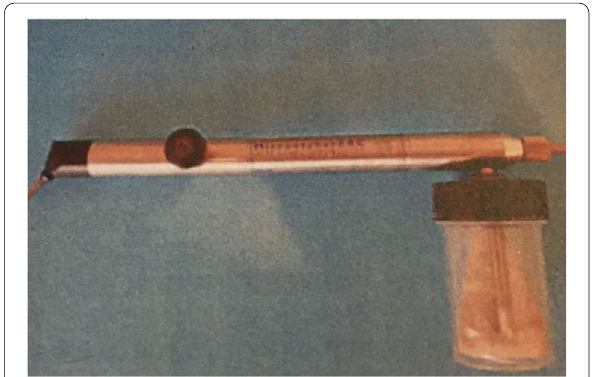
Fig. 3 Micro etcher machine used with Cojet repair system